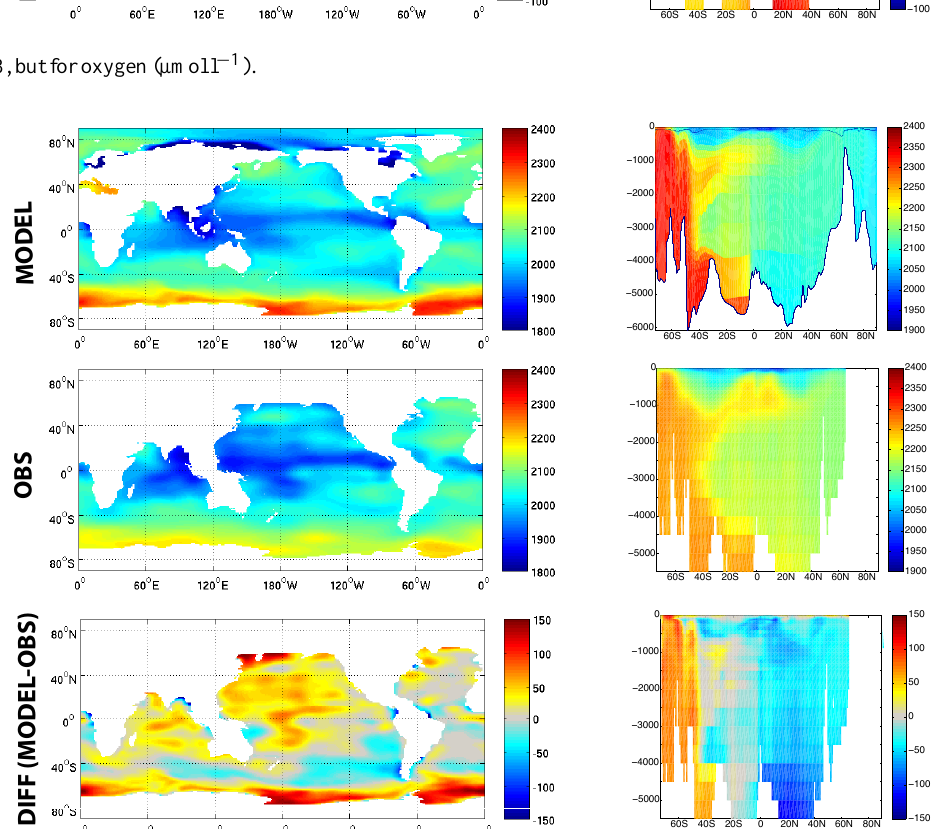
Fig. 12. As Fig. 3, but for DIC (µmoll − 1